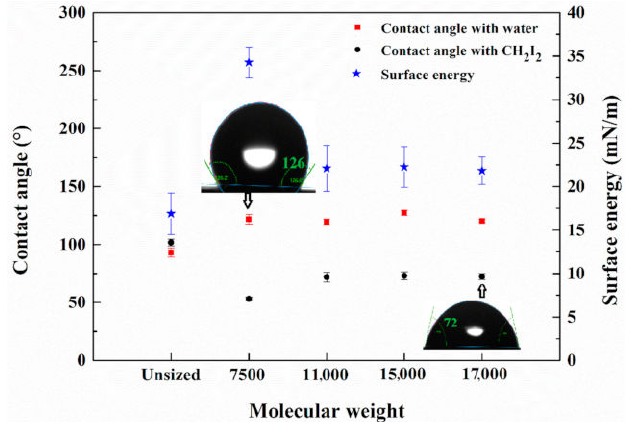
Figure 9. Surface energy and dynamic contact angles with water and CH 2 I 2 of sized CFs by sizing emulsions with the four di ff erent molecular